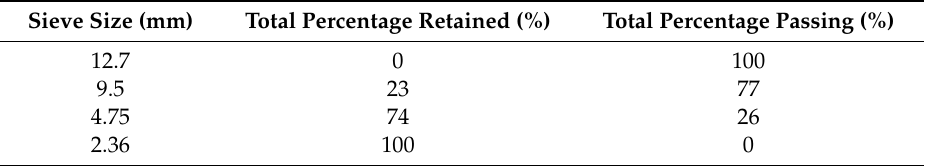
Table 1. Size distribution in Figure 3